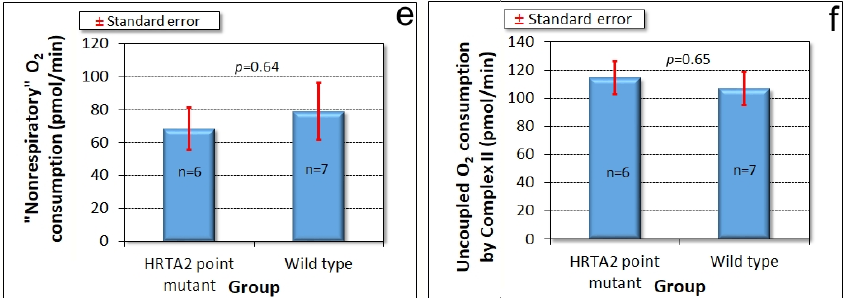
Figure 8. Mitochondrial respiration is unaffected by overexpression of protease-dead HTRA2 S300A . Seahorse respirometry was conducted in the indicated number (n) of independent experiments on wild type (AX2) cells and cells of four different HTRA2 S300A overexpression strains (antisense construct copy numbers ranging from 90 to 312). Basal respiration (a) and its components attributable to ATP synthesis (c) and “non-mitochondrial” respiration (e) were unaffected. The maximum respiration rate by CCCP-uncoupled mitochondria (b) and its components attributable to Complex I (d) and Complex II (f) were also not significantly altered. The copy number of the HTRA2 S300A overexpression construct had no significant effect on any of the parameters of respiration (Pearson correlation coefficient, n = 13,